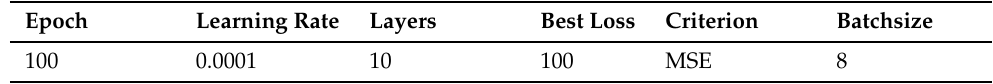
Table 1. Moiré simulating network